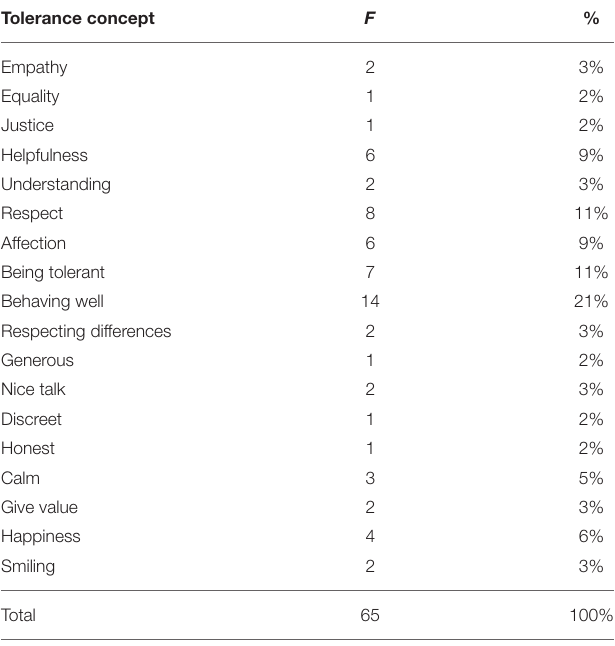
TABLE 1 | Students’ views on the concept of tolerance.